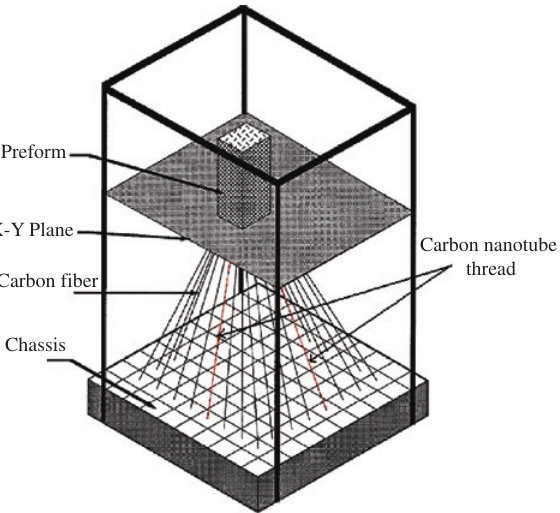
Figure 1: Schematic diagram of 3-D five directional braiding machine.